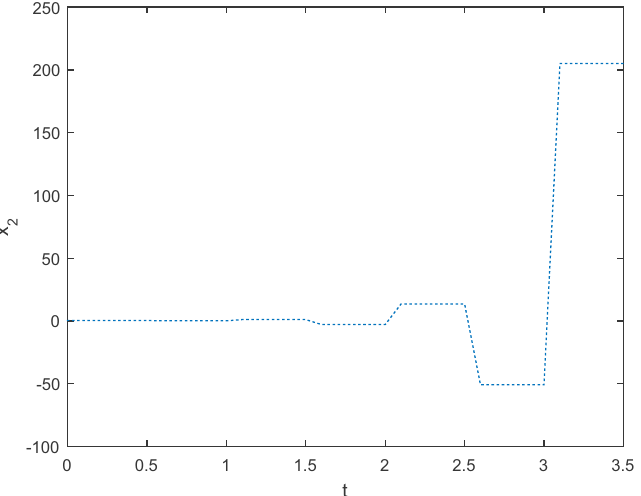
Figure 4. The unstable trajectory of the state variable x 2 ( t ) of the CNN in Example